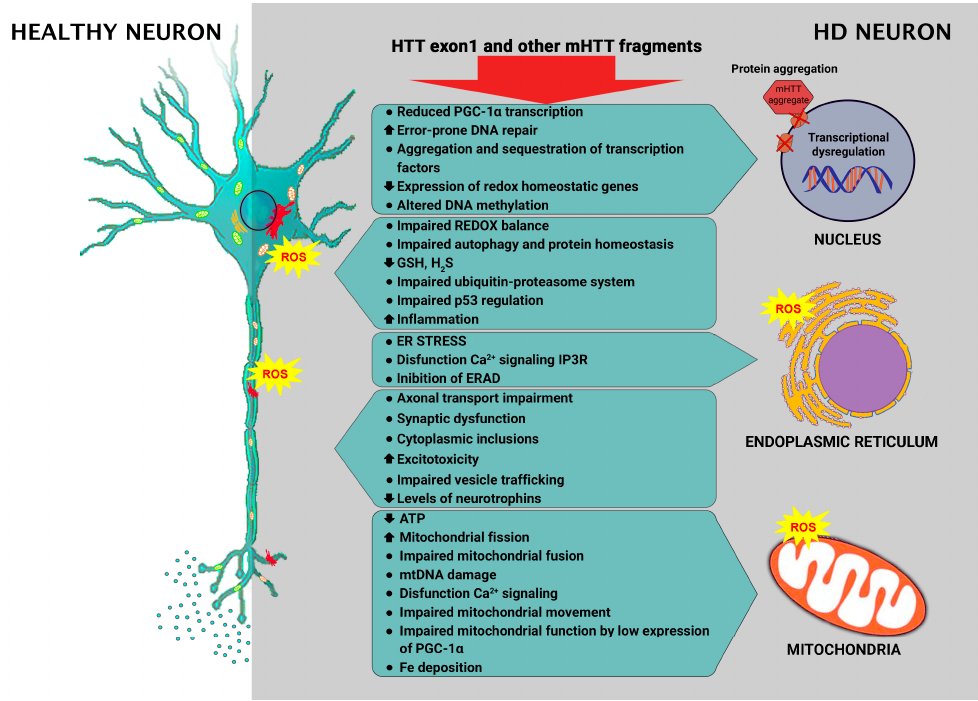
Figure 1. Pathogenetic mechanisms of HD responsible of neuron’s dysfunction and